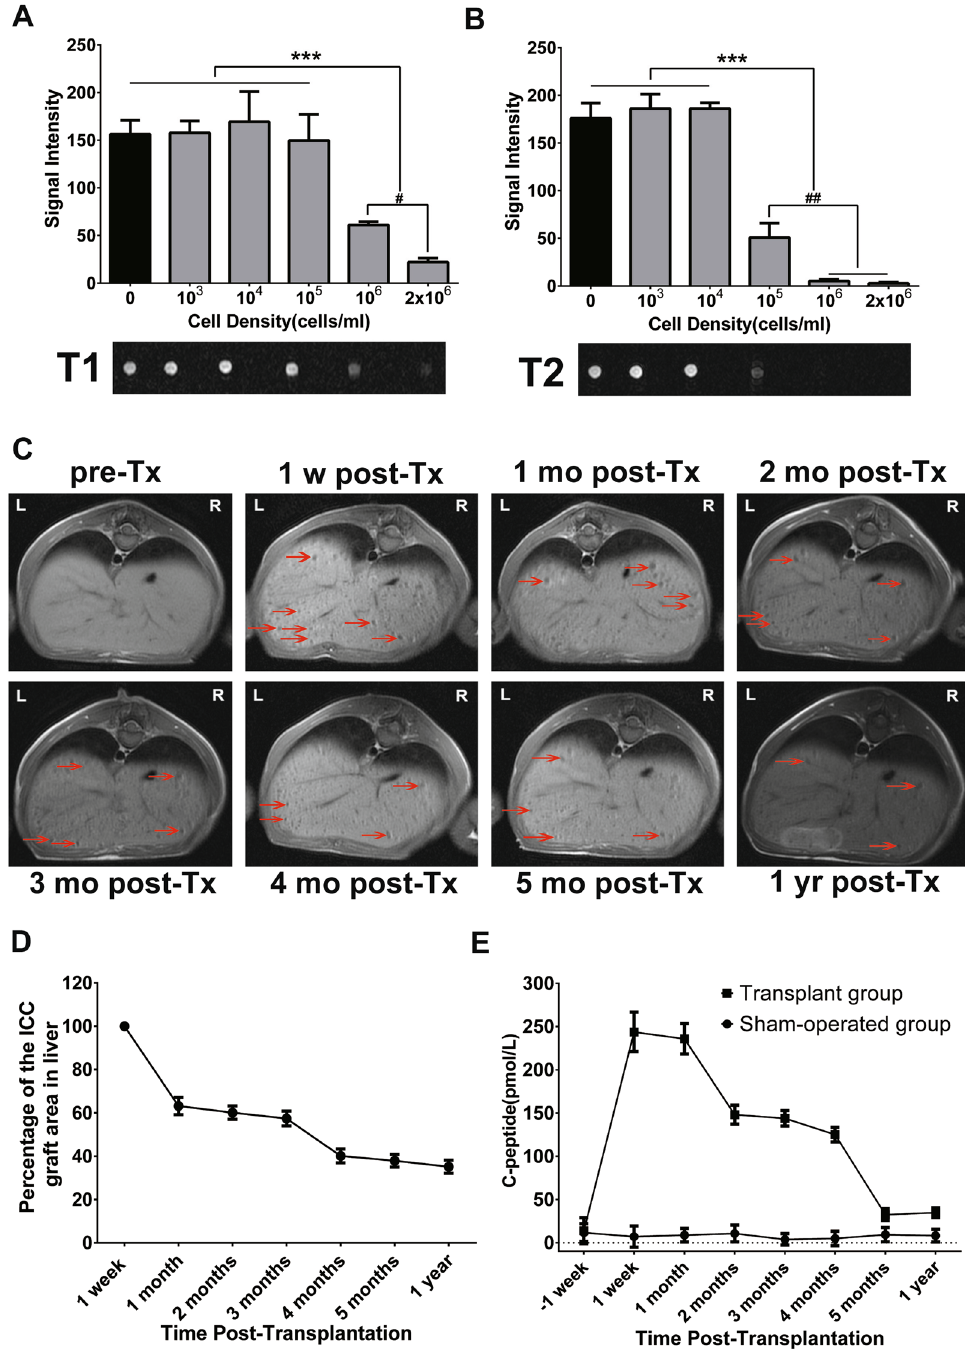
Figure 3. ( A and B ) Bar graphs showing the signal intensity values measured in gelatin phantoms containing SPION-labeled cells after overnight incubation with 100 μ g Fe/ml SPIONs at 37 °C. The graphs (top) and corresponding MR images (bottom) were obtained by T1-weighted imaging ( A ) and T2-weighted imaging ( B ). Quantitative analysis revealed a significant decrease in signal intensity of more than 10 6 cells/ml on T1-WI or more than 10 5 cells/ml on T2-WI. The results are shown as the mean ± SD, n = 3 (independent experiments); *** P < 0.001, # P < 0.05, ## P < 0.01. ( C ) Longitudinal MR imaging of labeled autologous ICCs transplanted via the intraportal route in diabetic monkeys. The arrows indicate hypointense spots, which are representative of labeled ICCs. ( D ) Semiquantitative assessment of graft survival time revealed a significant drop in graft areas from week 1 to month 1 and from month 3 to month 4 after transplantation. ( E ) Fasting C-peptide levels were measured in the sham-operated group or the transplant group throughout the follow-up period. The monkeys engrafted with autologous PPC-derived IPCs showed a significant increase in fasting C-peptide levels after transplantation, whereas the sham-operated animals did